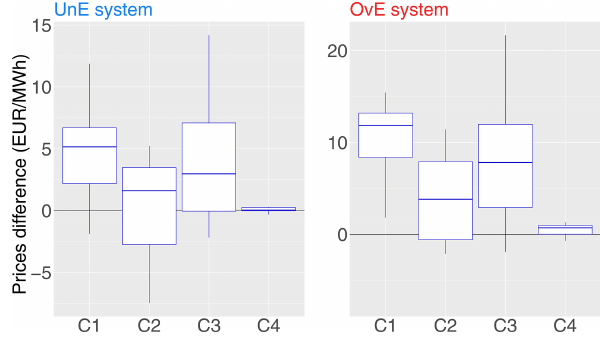
Figure 12. Differences in median electricity prices between the reference system (i.e., the “perfect system”, where forecasts are equal to observations) and two synthetic ensemble forecasting sys- tems: underestimating system (UnE, blue) and overestimating sys- tem (OvE, red). Differences are pooled into four classes of pro- duction rate (from lower C1 to higher C4 production rate). Syn- thetic systems are based on ensembles generated with spread fac- tors of 4%. Boxplots represent the maximum value, percentiles 75, 50 and 25, and minimum value over the 10 studied